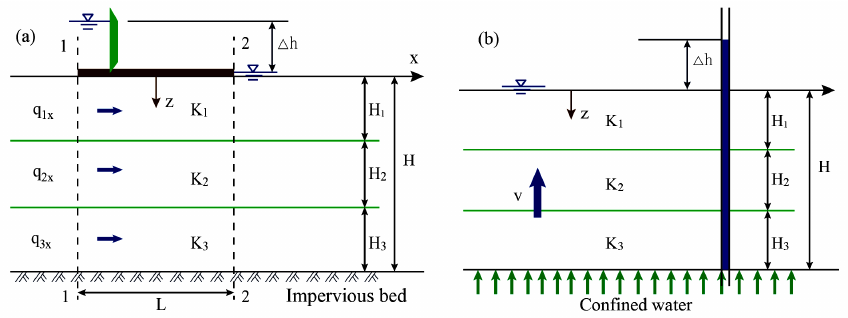
Figure 18. Schematic diagram of percolation in layered stratum. ( a ) Penetration coefficient in the direction of parallel planes, ( b ) Permeability coefficient in the vertical plane direction.